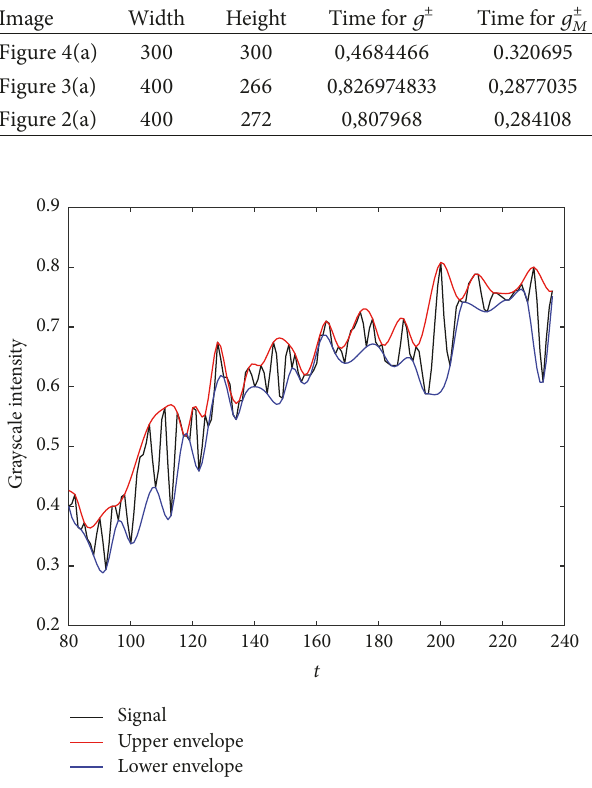
Figure 1: The effectiveness of envelope computation using 𝑔 𝑀 instead of 𝑔 .